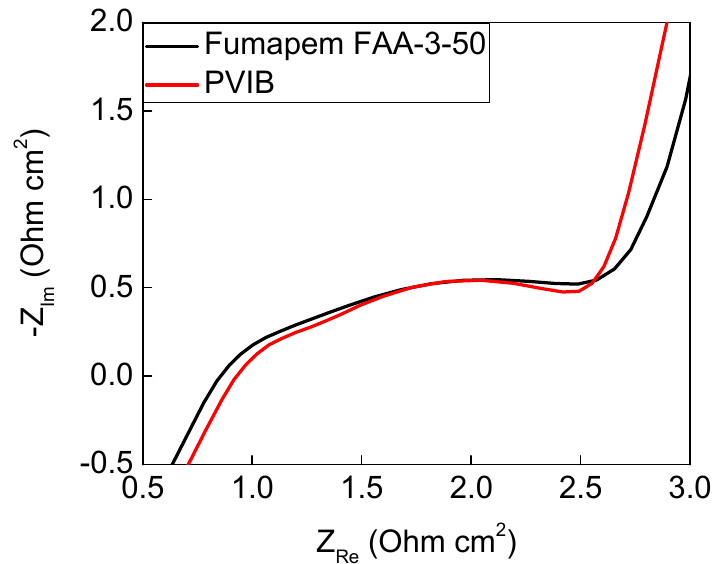
Figure 7. EIS comparison between commercial Fumapem and PVIB-10 at 70 °C when used in the electrolyser. Both the anolyte and catholyte were 1 M NaOH. Upon repeated testing of the PVIB-10 membranes in this electrolyser setup, it was